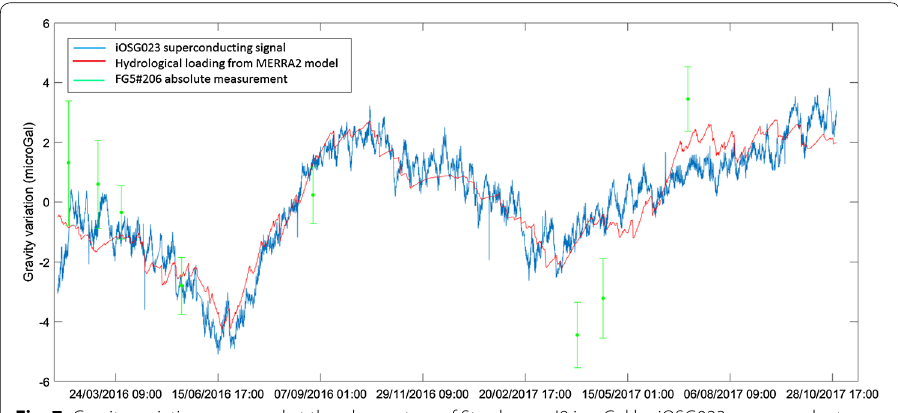
Fig. 7 Gravity variation measured at the observatory of Strasbourg J9 in µGal by iOSG023 superconduct‑ ing gravimeter (blue curve). This signal is corrected for the effect of solid Earth and ocean loading tide, atmospheric pressure, polar motion and instrumental drift. It is linked to the hydrological loading (red curve) obtained with MERRA2 model (Boy 2018). FG5#206 absolute measurements and their errors corrected for the effect of solid Earth and ocean loading tide, atmospheric pressure, polar motion are represented in